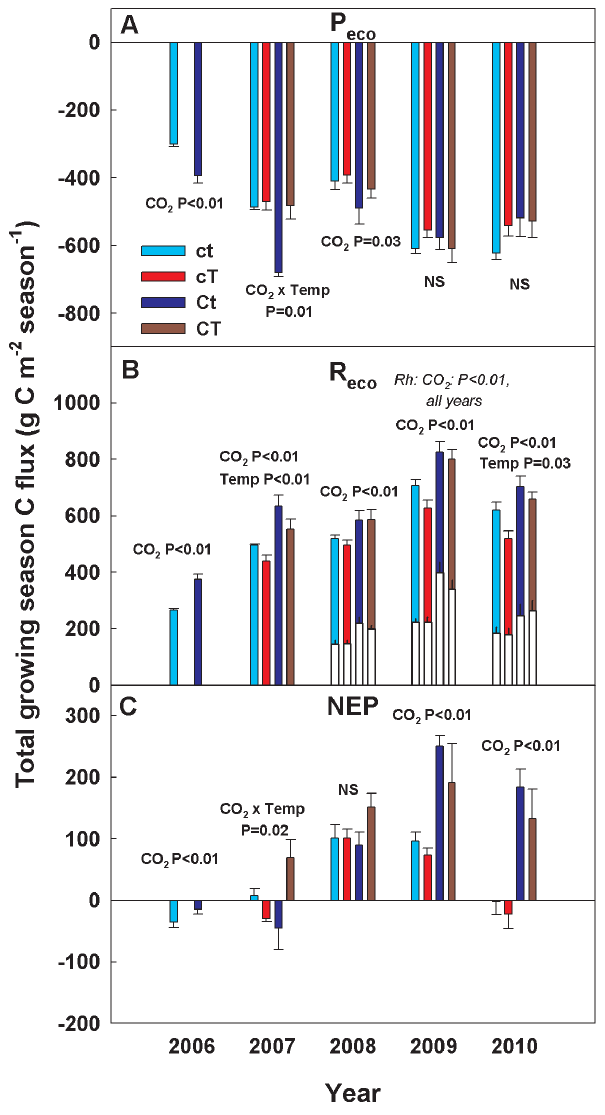
Figure 1. Growing season carbon fluxes in response to global changes. Growing season sums (April–October, 2006–2010) for A) gross ecosystem production (P eco ), B) ecosystem respiration (R eco ) and heterotrophic respiration (Rh) inset white bars, and C) net ecosystem production (NEP) for control and global change treatments at the Prairie Heating and CO 2 Enrichment Experiment in Cheyenne, WY USA. Negative (–) values indicate C uptake and positive ( + ) values indicate C efflux. Treatment codes are: ct=ambient [CO 2 ] and temperature, cT=ambient [CO 2 ] and warming, Ct=elevated [CO 2 ] and ambient temperature, and CT=elevated [CO 2 ] and warming. Statistically significant main and interactive treatment effects (within a given year) along with p-values are indicated (n=5 for all